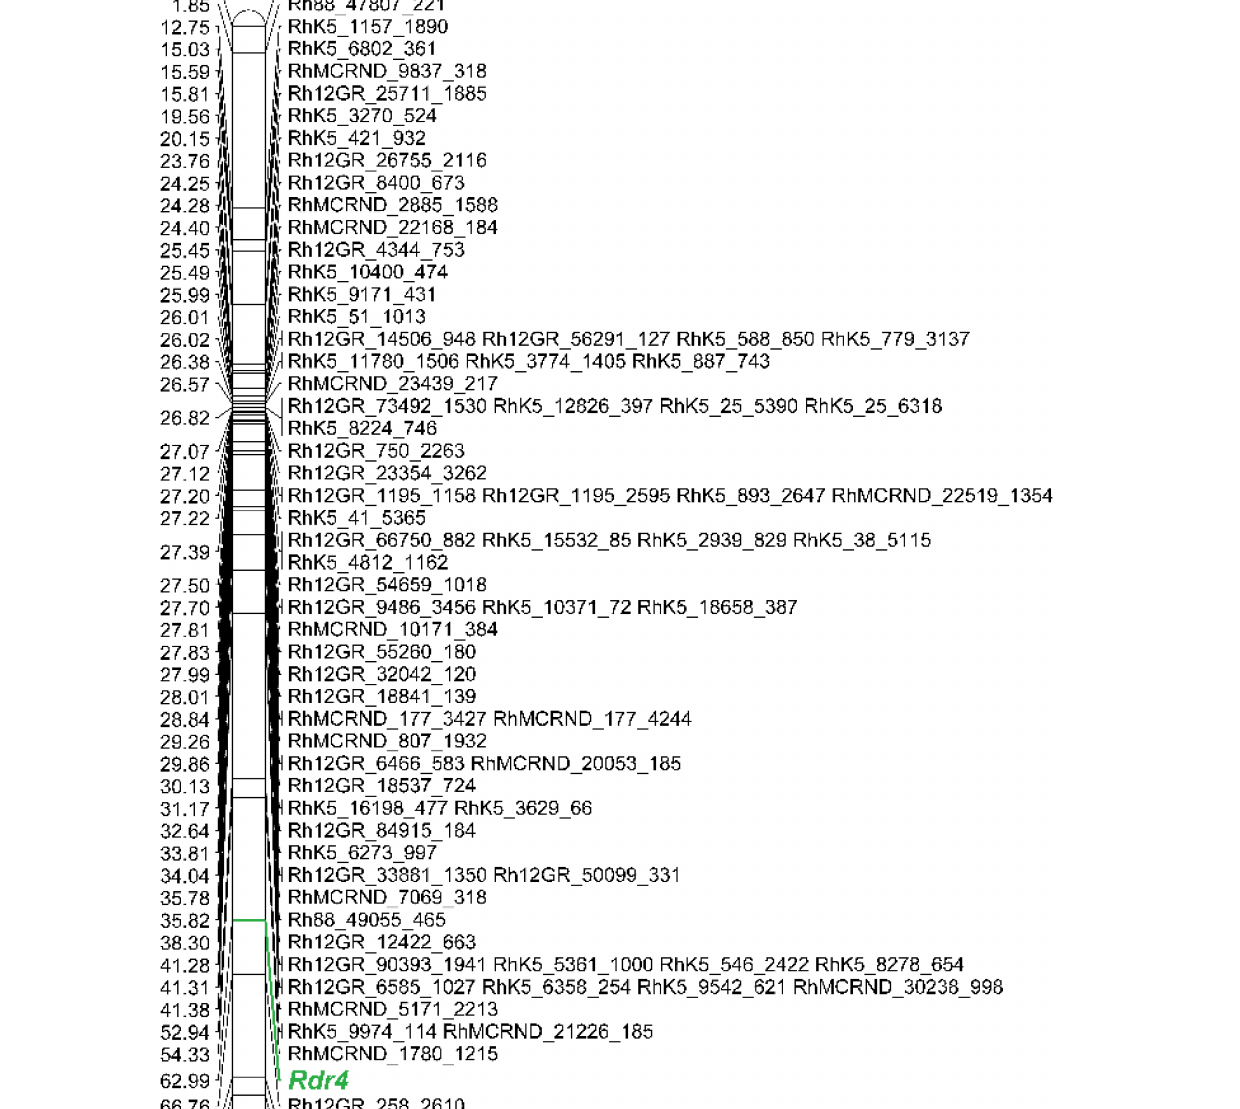
tetraploid segregation ratios, 13,682 SNP markers